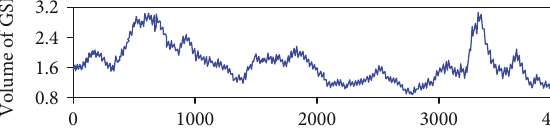
Figure 5: Power spectrum of the manufacturing system.